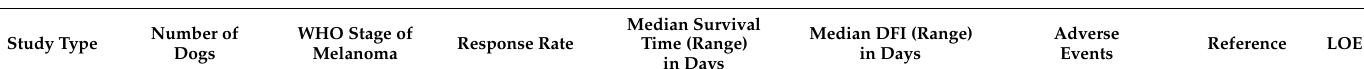
Overall Evidence Grade: